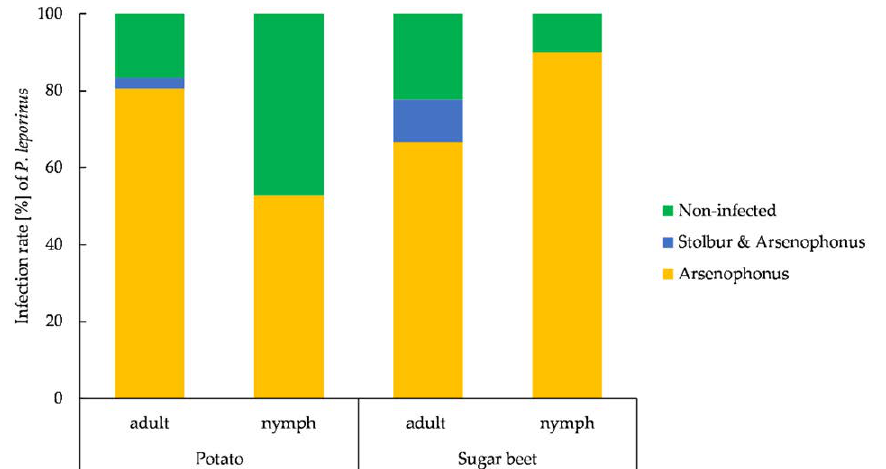
Figure 4. Prevalence of Candidatus Arsenophonus phytopathogenicus (Arsenophonus) and Candidatus Phytoplasma solani (stolbur) in Pentastiridius leporinus adults (n = 36) and nymphs (n = 36) on potato, and adults (n = 9) and nymphs (n = 10) on sugar beet plants, as determined by qRT-PCR. Nymphs and adults were collected in September 2022.